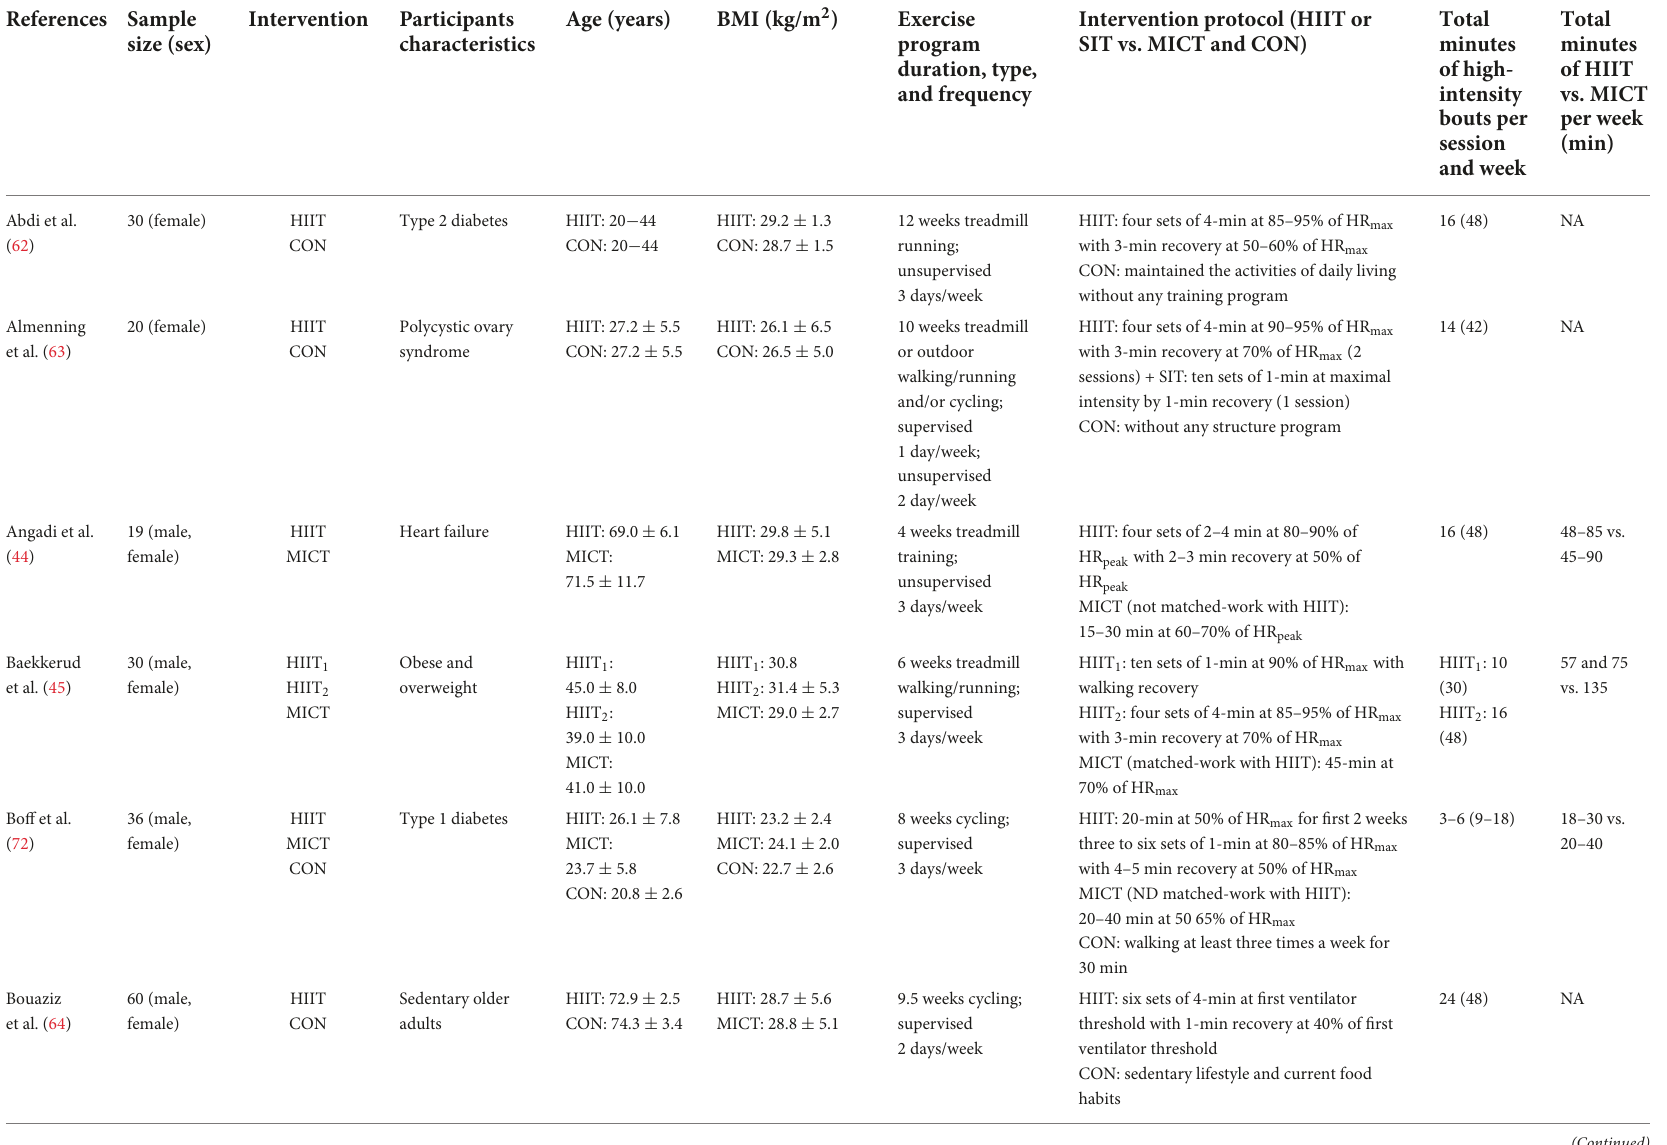
TABLE 1 Characteristics of the participants and